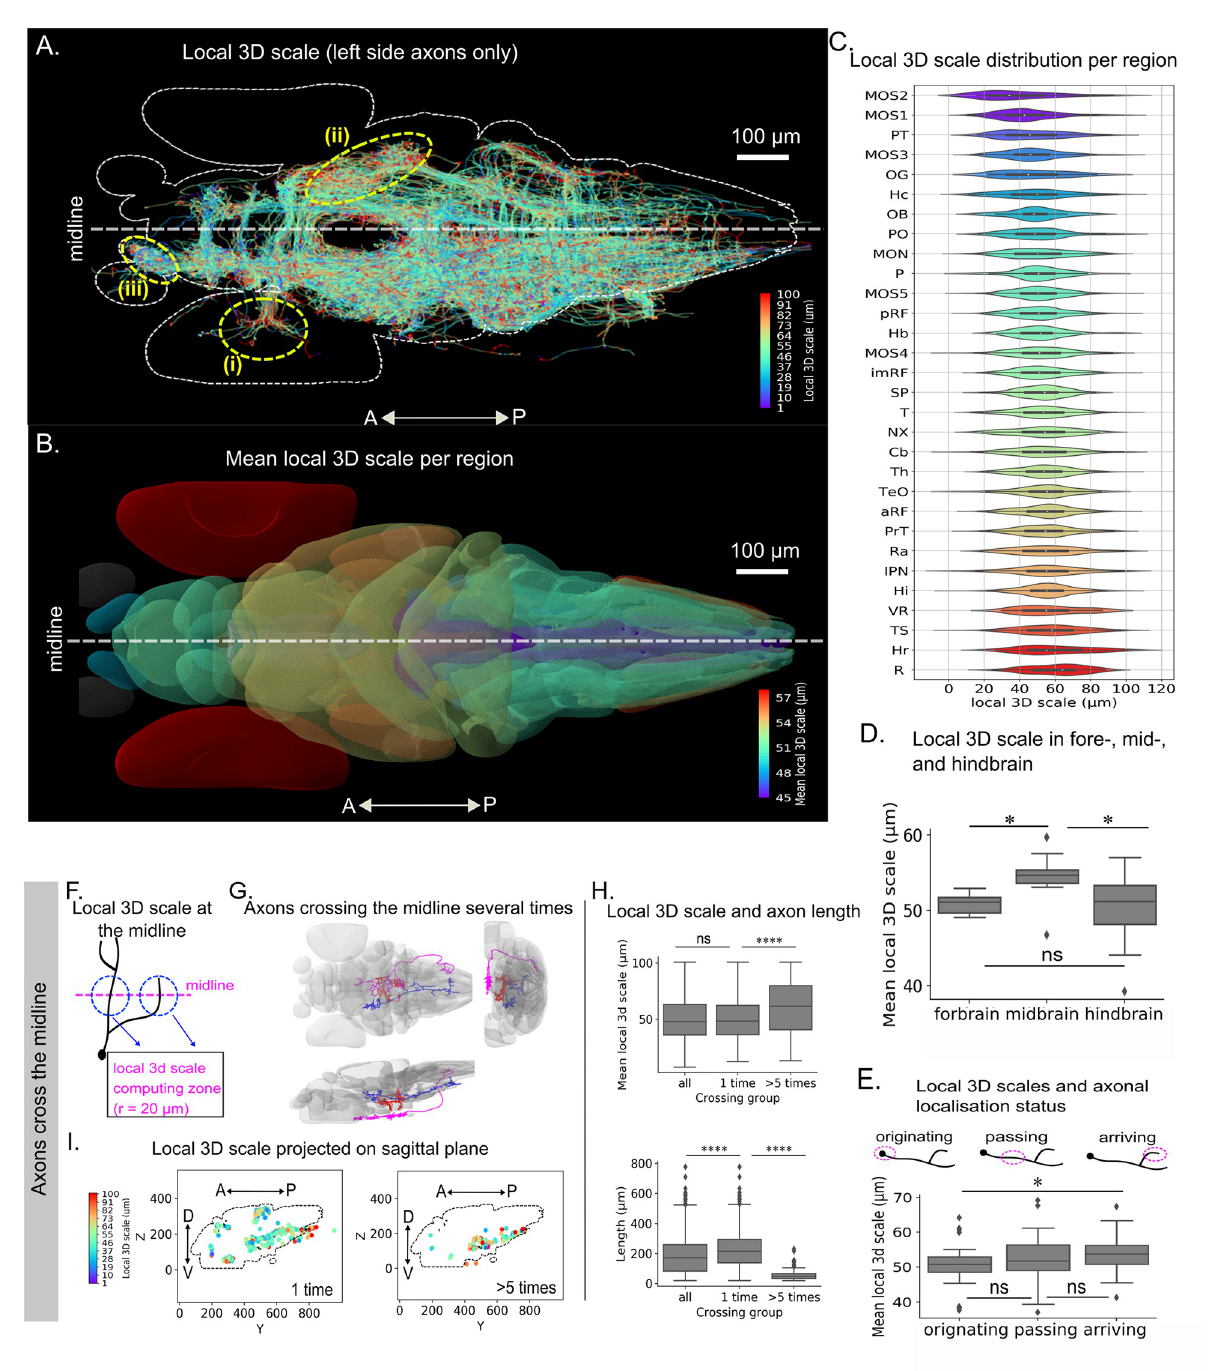
Fig 3. Local 3D scale mapping across the whole larval zebrafish brain. Traces analyzed correspond to those presented in [12]. (A) Local 3D scale analysis of all axonal traces originating from neurons in the left hemisphere; the maximum scale is set to 100 μ m based on the width of the largest brain region. (B) Mean local 3D scale by brain regions. Regions with fewer than 15 traces were excluded (in gray). Values were clipped from the 5th to 95th percentiles for clearer display. (C) Distribution of the local 3D scale values in each brain region (see Table A of S1 Text for abbreviation definitions). (D) Mean local 3D scale in fore-, mid- and hindbrain regions (E) Mean local 3D scale of axons originating from, passing through, and arriving in each brain region. (F) Example of axonal arbors with many branches crossing the midline. (G) Diagram summarizing computation of the local 3D scale at the midline. (H) Local 3D scale (top) and length (bottom) of all axons crossing the midline vs. those crossing only once and more than five times. (I) View of the midline sagittal plane showing the local 3D scale of axons crossing only once and more than five times. The maximum scale is set to 100 μ m based on the width of the largest brain region analyzed. Wilcoxon tests with Holm-Sidak correction for multiple comparison was used, � p � 0.05, �� p � 0.01, ��� p � 0.005, ���� p � 0.001. Color scale in C corresponds to that used in B.